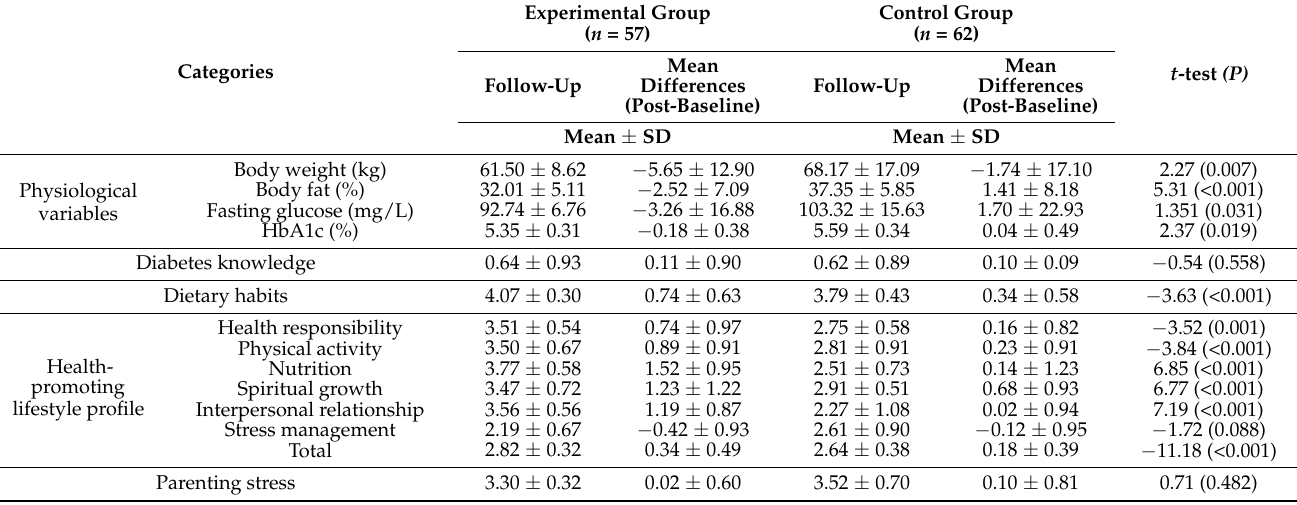
Table 3. Intervention outcomes in the experimental group and the control